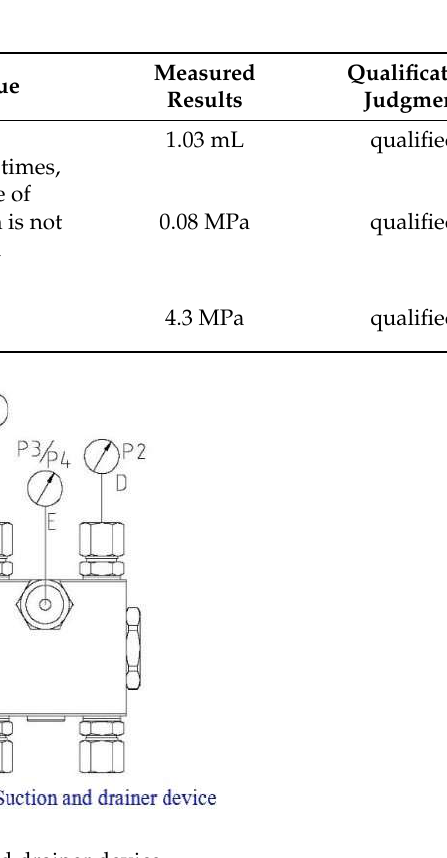
Figure 7. The structure of the tested suction and drainer device.